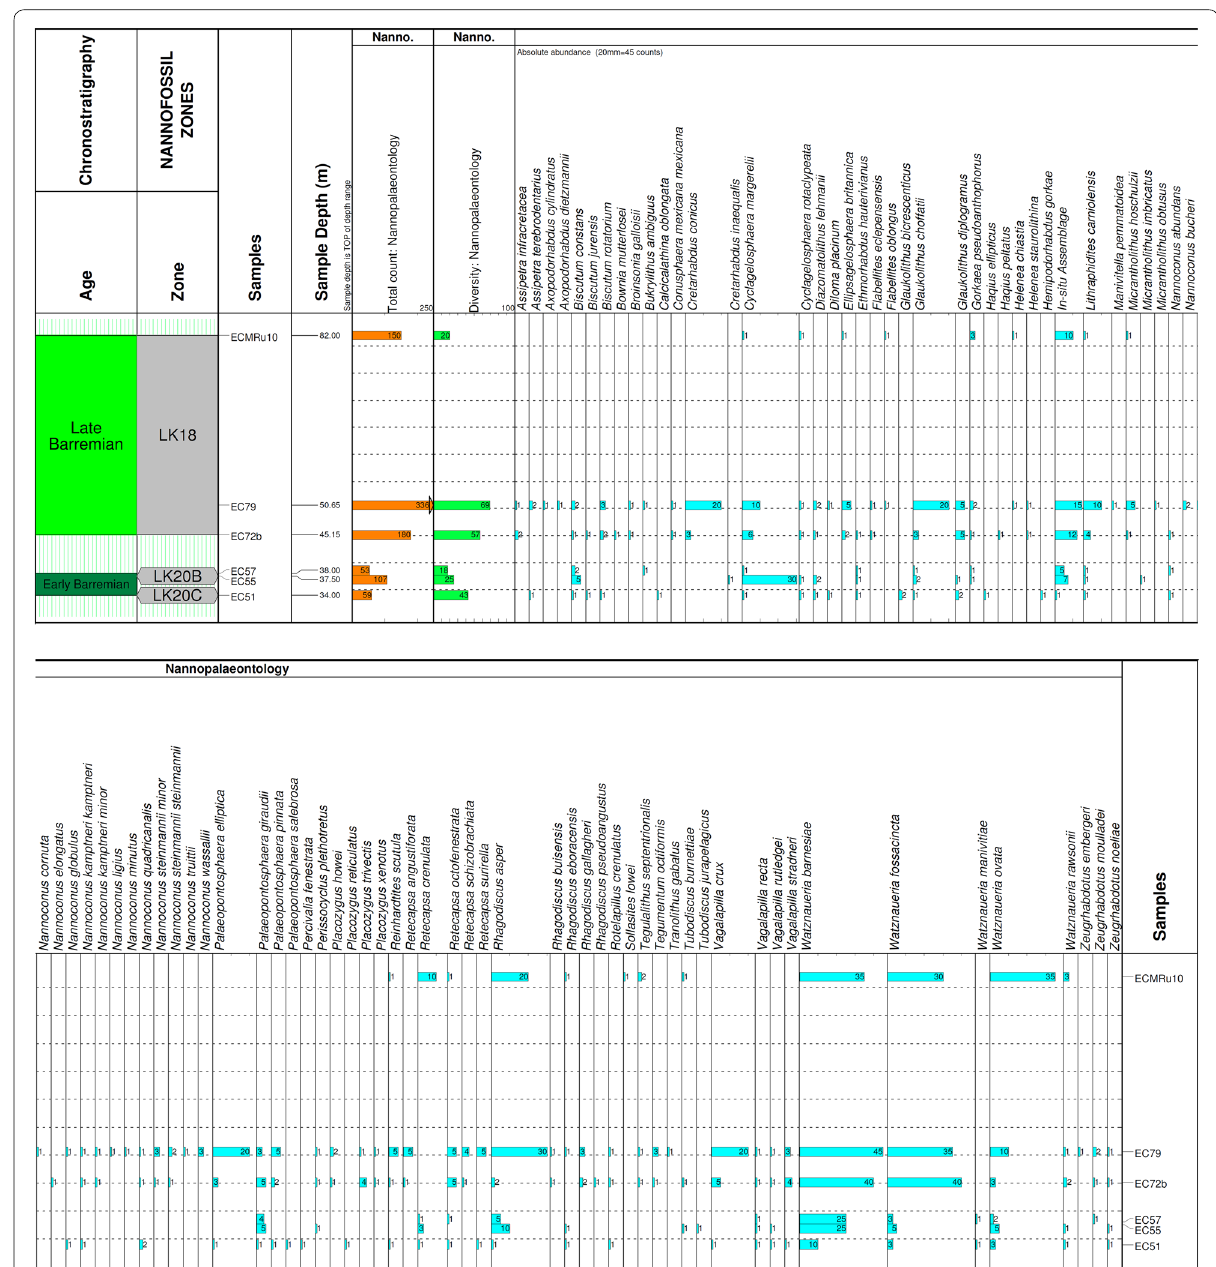
Fig. 13 Nannofloras from the Marnes de la Russille (MRu) in the Eclépens quarry (EC)